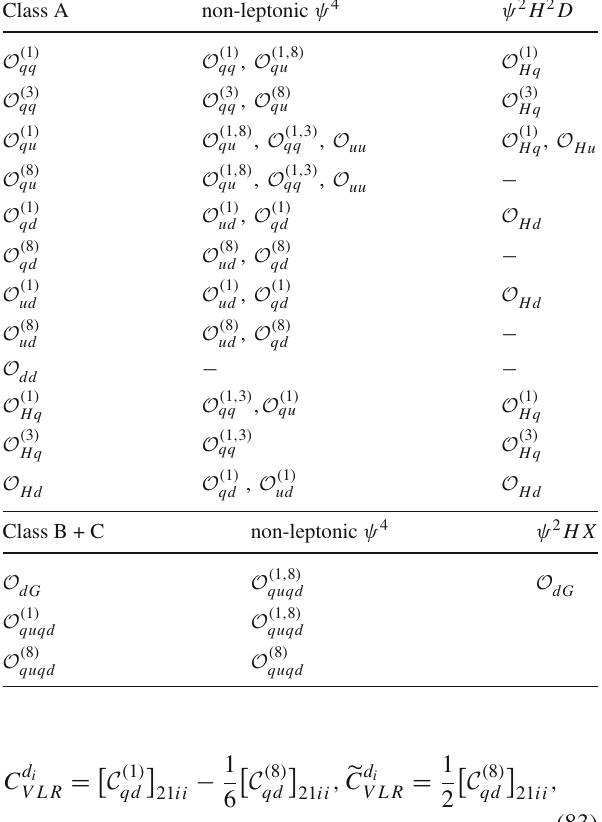
Table 13 List of four-quark operators in Classes A–C that receive at one-loop in SMEFT contributions from non-leptonic ψ 4 and ψ 2 H 2 D operators through mixing via the top-quark Yukawa coupling. Self- mixing is included. We have omitted O (Class E) that only mixes Hud with itself through the top Yukawa